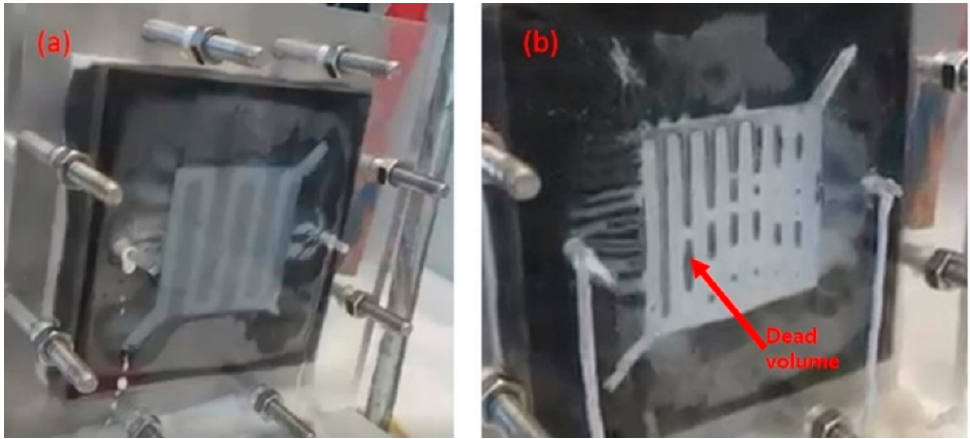
Figure 5. Distribution of the zinc slurry in the serpentine ( a ) and parallel ( b ) flow fields.